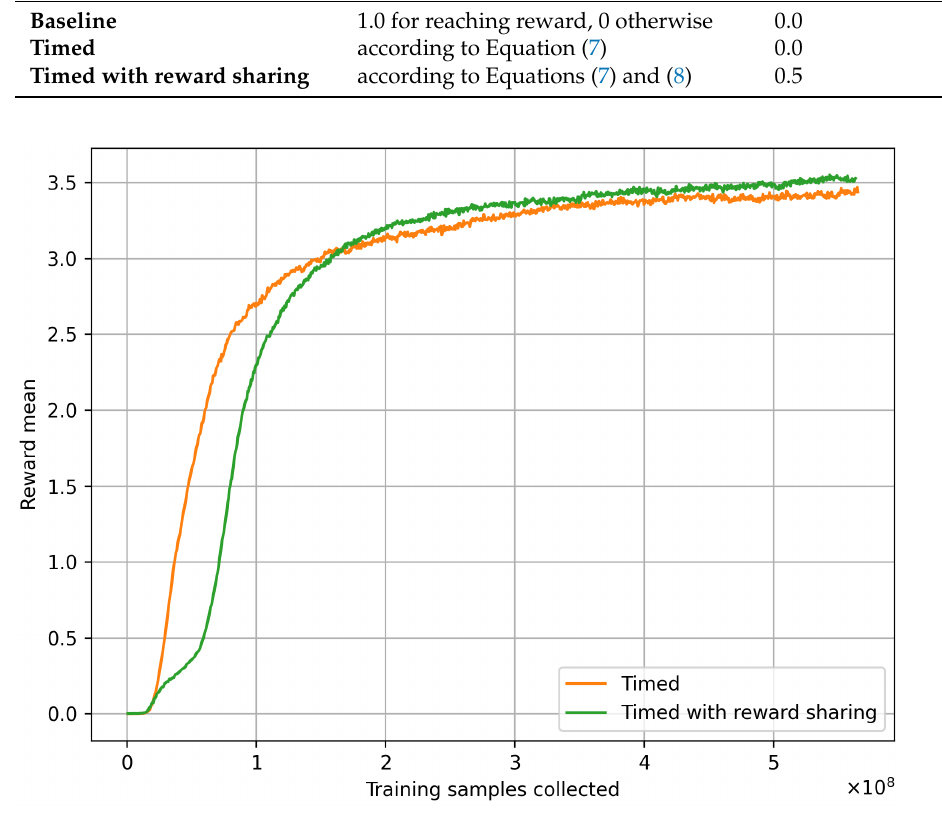
Figure 9. Graph presenting the training progress regarding the mean reward achieved in each training iteration. The reward-sharing mechanism slowed down the training progress in the beginning but resulted in a better performance in the